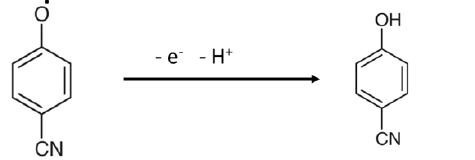
Scheme 2. Proposed electrochemical oxidation mechanism of 4-CP on CGO/PEDOT:PSS/Au / μ -Chip assembly.